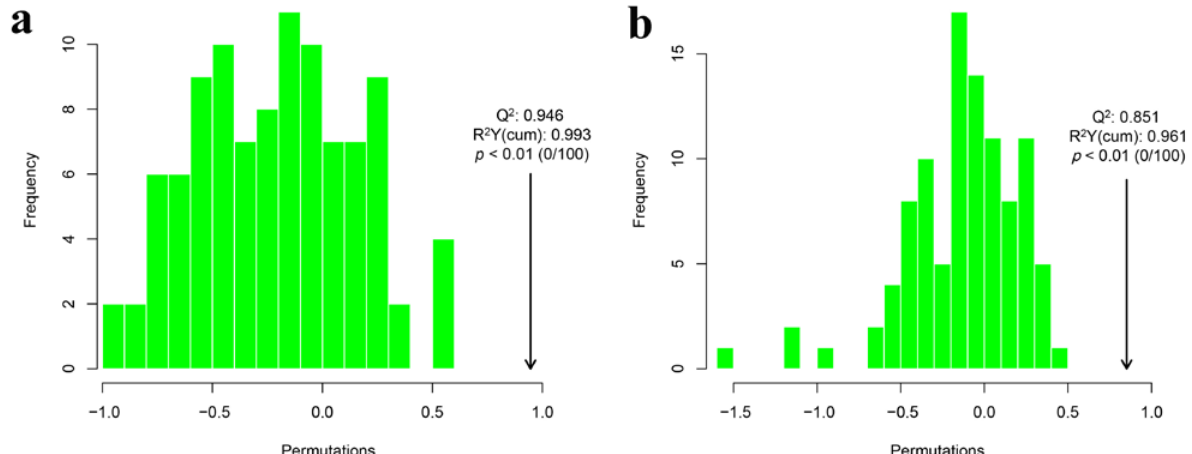
Figure 12. Non-targeted lipidomics test statistics: (Q 2 ) distribution, the R 2 Y (cum), and p -value of OPLS-DA replacement test for camellia oil before and after heating. ( a ) Positive ion mode; ( b ) negative ion mode.